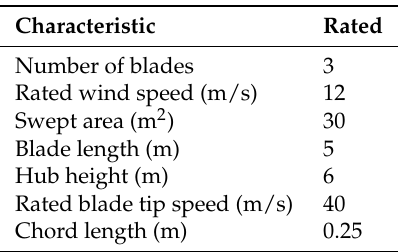
Table 3. Turbine parameters for the 12 kW